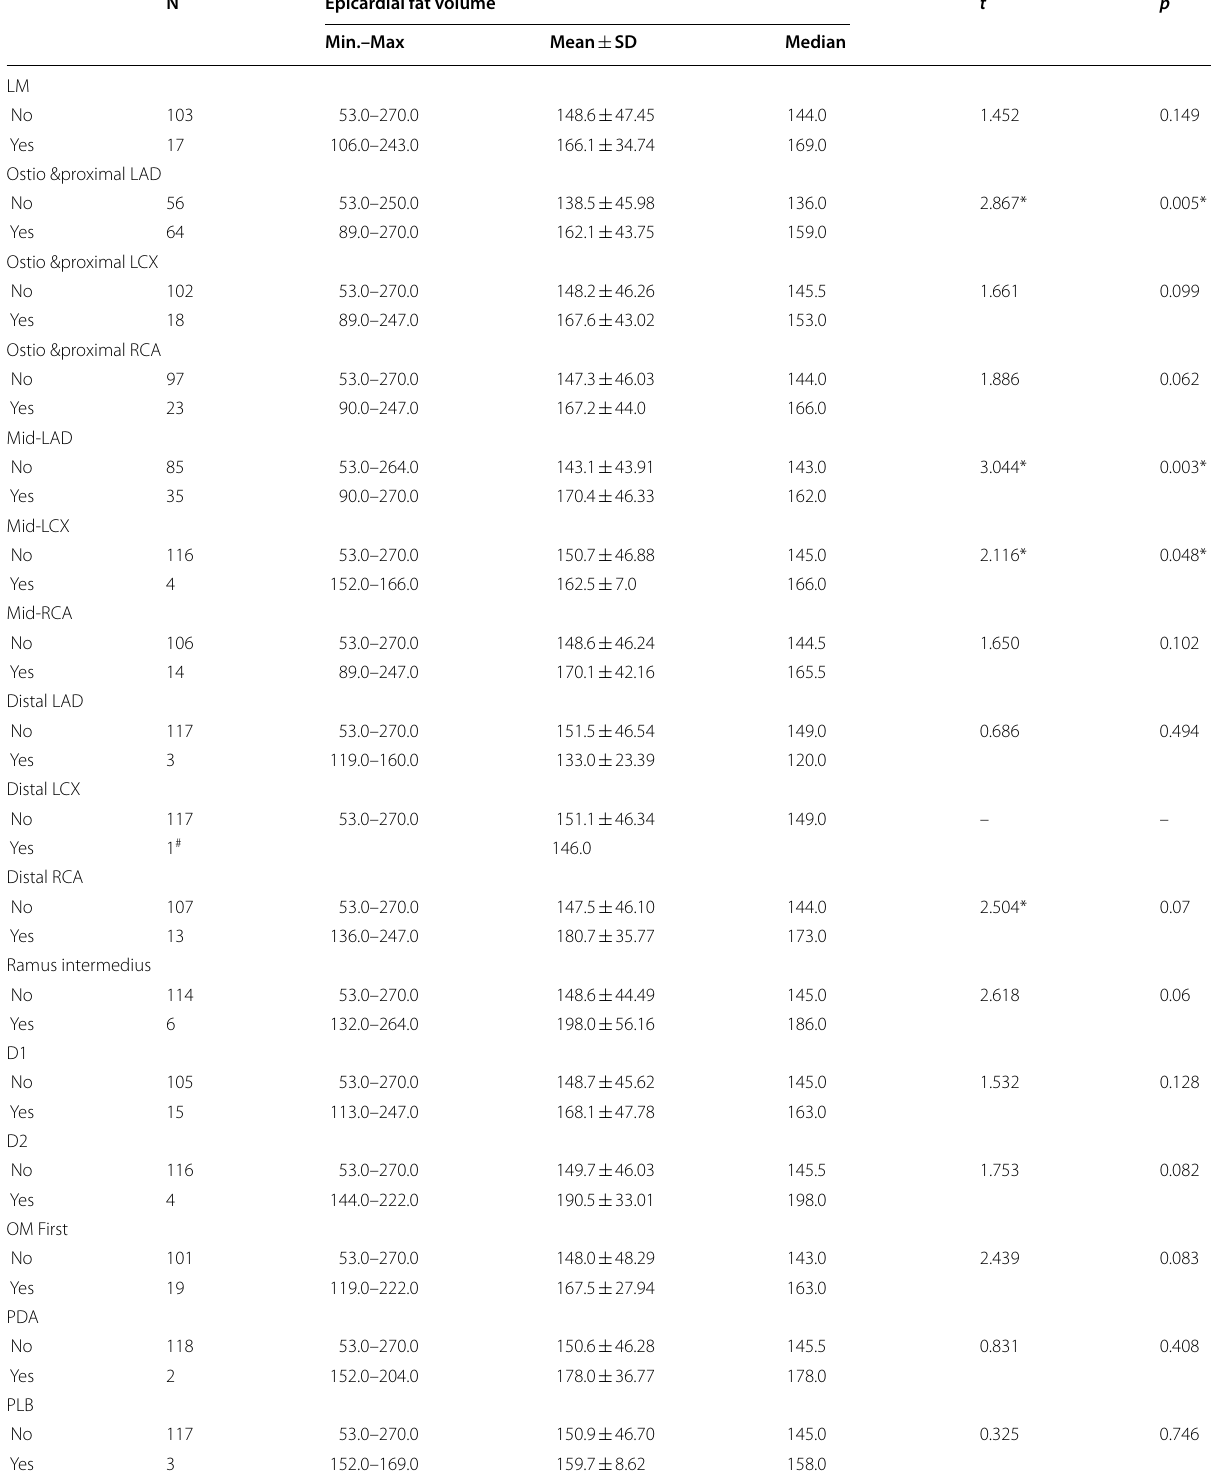
Table 6 Relation between epicardial fat volume and segmental lesion ( n